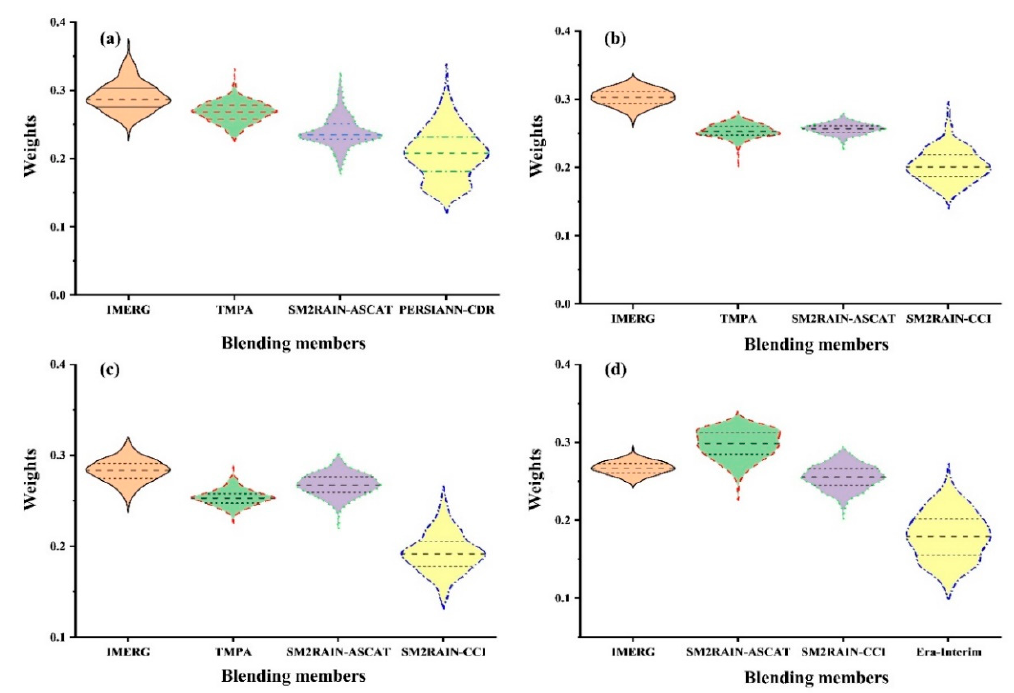
Figure 3. Violin plots showing the probability density of the autoregressive integrated moving average (ARIMA) model forecasted weights across the regions. ( a ) Glacial; ( b ) Humid; ( c ) Arid; ( d ) Hyper-arid regions. Three lines inside the violin plots represent three quartiles.